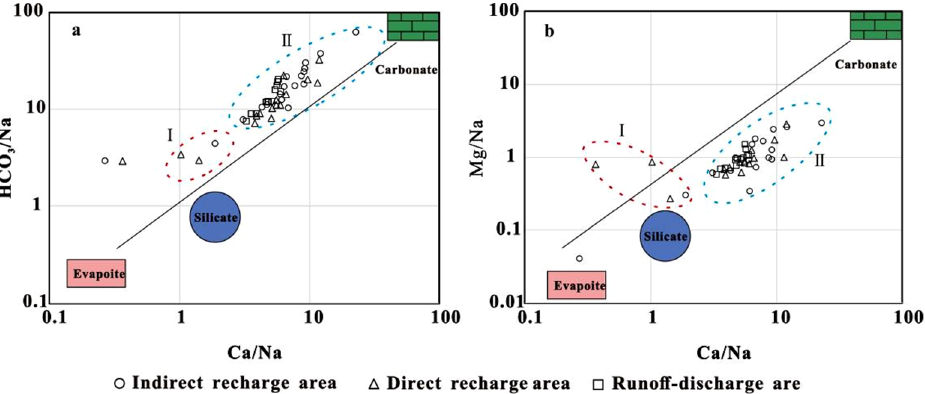
Figure 4. Ion ratio scatter map of karst water in the Baotu karst spring system (( a ) HCO 3 /Na and ( b ) Mg/Na).